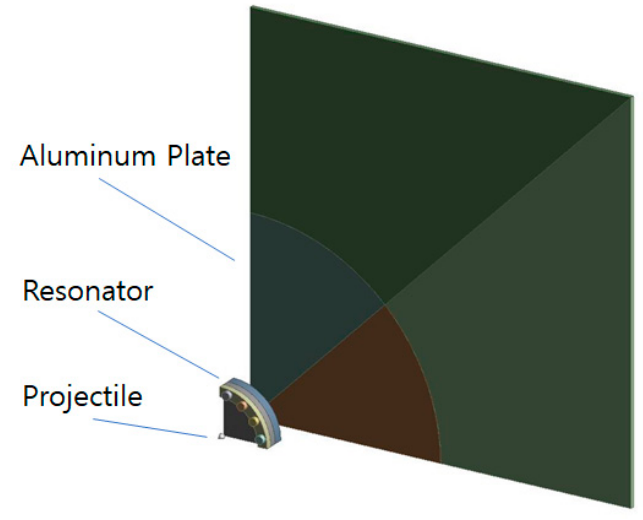
Figure 9. Modal analysis results according to thickness of resonator.